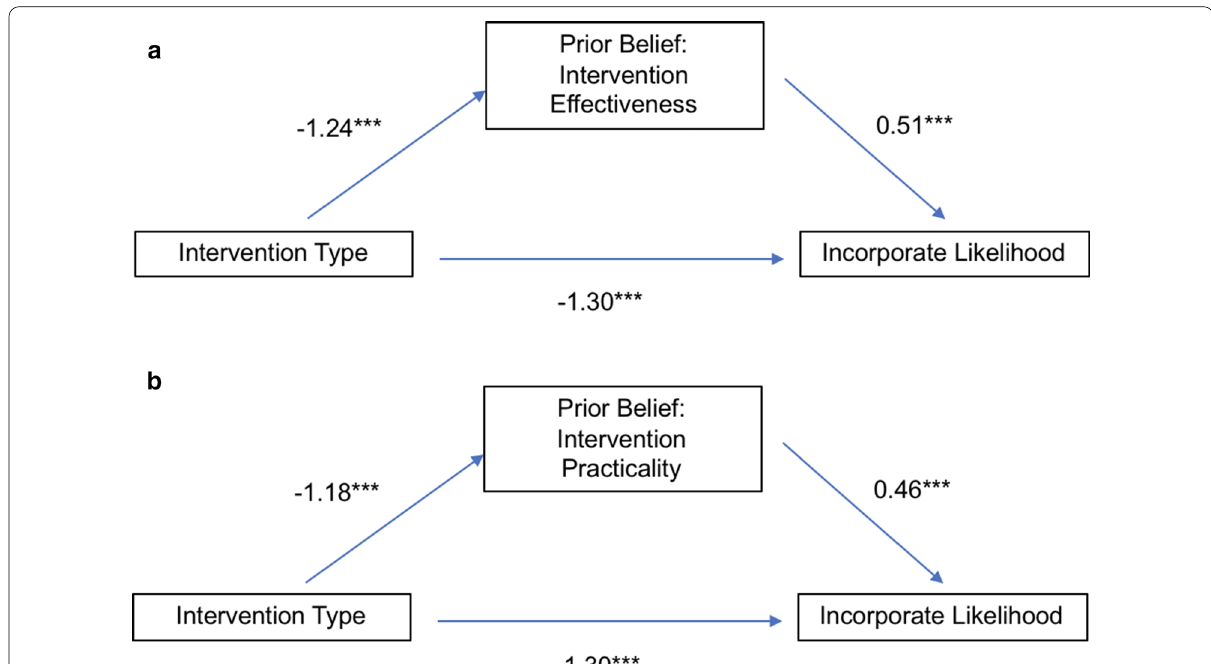
Fig. 4 Mediation analysis showing direct and indirect effects of intervention type as mediated by prior beliefs about intervention effectiveness ( a ) and intervention practicality ( b ) on incorporate likelihood